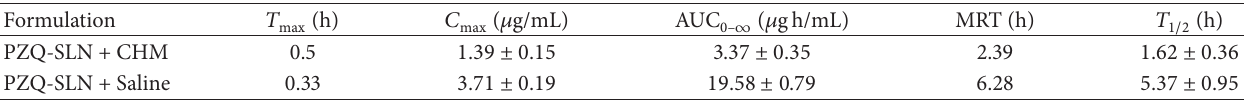
Table 5: Pharmacokinetic parameters for praziquantel in rats after intraduodenal administration of PZQ-SLNs at an equivalent praziquantel dose of 50mg/kg to rats treated with cycloheximide (CHM) and saline, respectively (values are means ± SD, 𝑛 = 6 ).